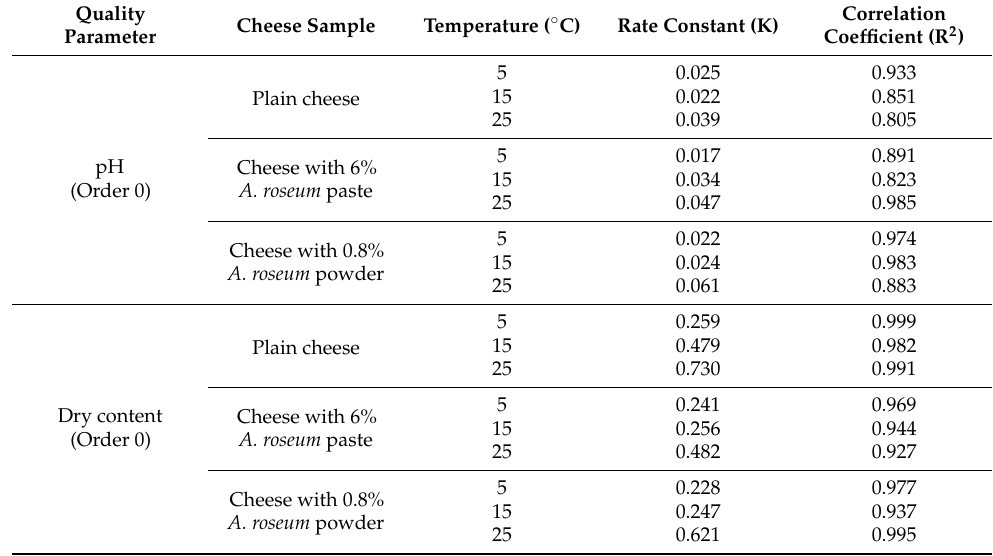
Table 4. Calculation of rate constant and correlation coefficient values from zero-order and from first-order